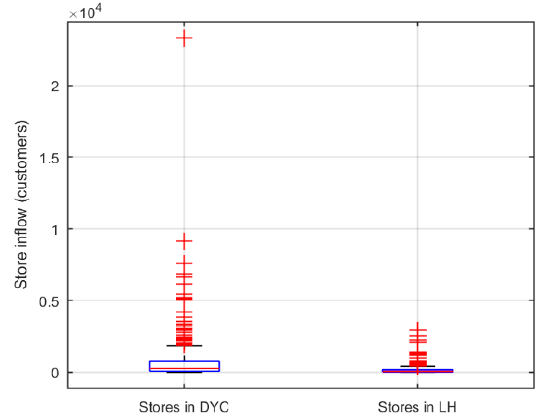
Figure 6. Boxplot of store inflow.